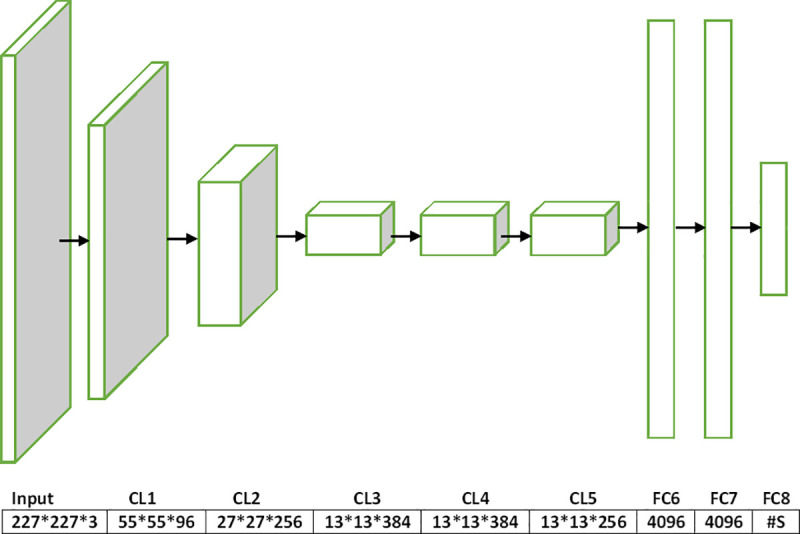
The schema of the modified AlexNet, where (#S) is the number of subjects in the dataset used during training.